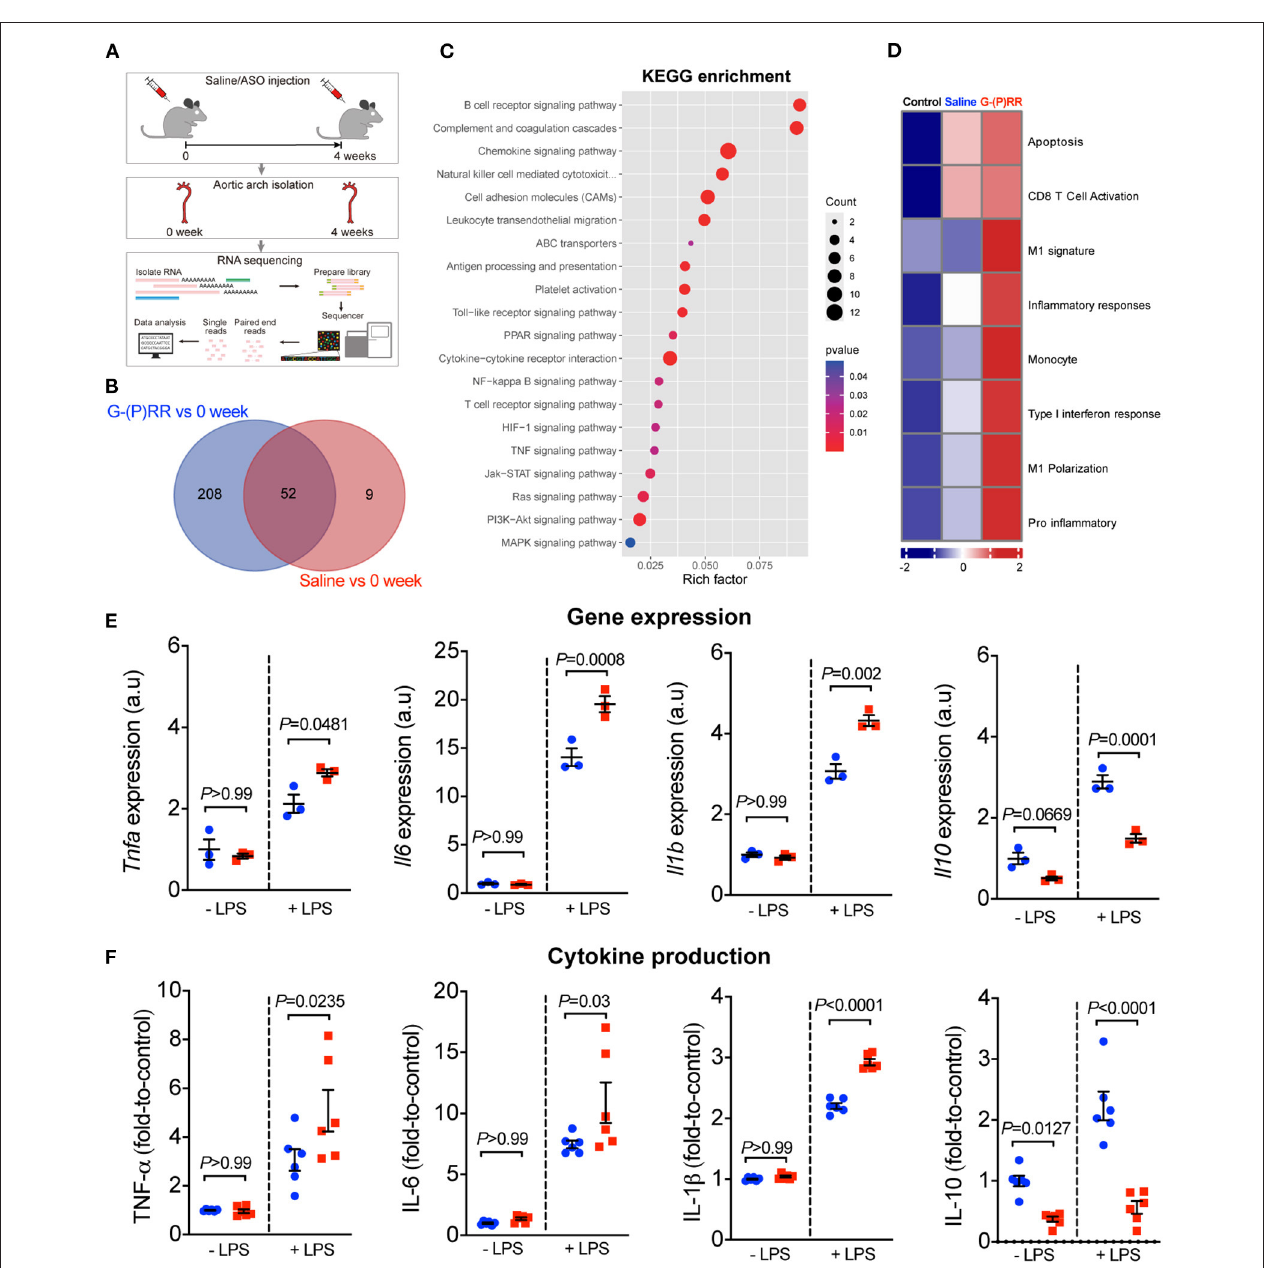
FIGURE 3 | (P)RR G-ASOs promoted immune responses in aorta by augmenting macrophage inflammatory cytokine production. (A–D) Eight-week-old LDLR − / − mice were administered with either saline or (P)RR G-ASOs and fed a WTD for 4 weeks, and aortas were isolated for transcriptomic analyses. Aortas from 8-week-old LDLR − / − mice (0 week) served as control. Experimental procedure (A) . Venn graph showing overlapped and non-overlapped DEGs (B) . KEGG enrichment analysis (C) and GSVA analysis of curated gene sets (D) . (E,F) RAW264.7 cells were incubated with saline (blue) or (P)RR G-ASOs (red) and stimulated with or without LPS. Expression and production of cytokines were